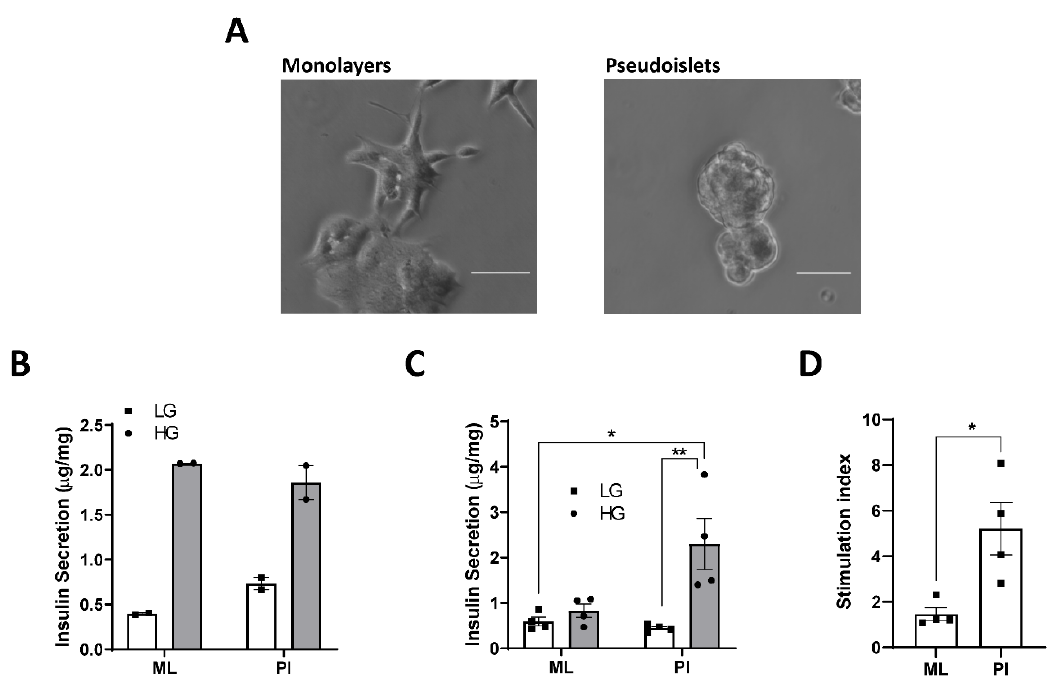
Figure 1. Configuration of MIN6 as pseudoislets improves GSIS. MIN6 cells (passage 22–26 ( B ) or 26–30 ( C , D )) were cultured in either standard cell culture plates (Monolayers, ML) or un ‐ coated Petri ‐ dishes (Pseudoislets, PI) for 5 days. ( A ) Cells were imaged using light microscopy. ( B , C ). Insulin secretion at low (LG, 3–5 mM) or high (HG, 25 mM) glucose was determined in ML and PI for 1 hour and expressed as μ g insulin/h/mg protein. n = 2 ( B ) or 4 ( C ). ( D ) The stimulation index was calculated as the ratio of stimulated (HG) to basal insulin secretion (LG). n = 4. * p < 0.05, ** p < 0.01 using a 2 ‐ way ANOVA followed by Bonferroni post hoc test ( C ) or an unpaired student t ‐ test ( D ). Scale bars represent 100 μ m.